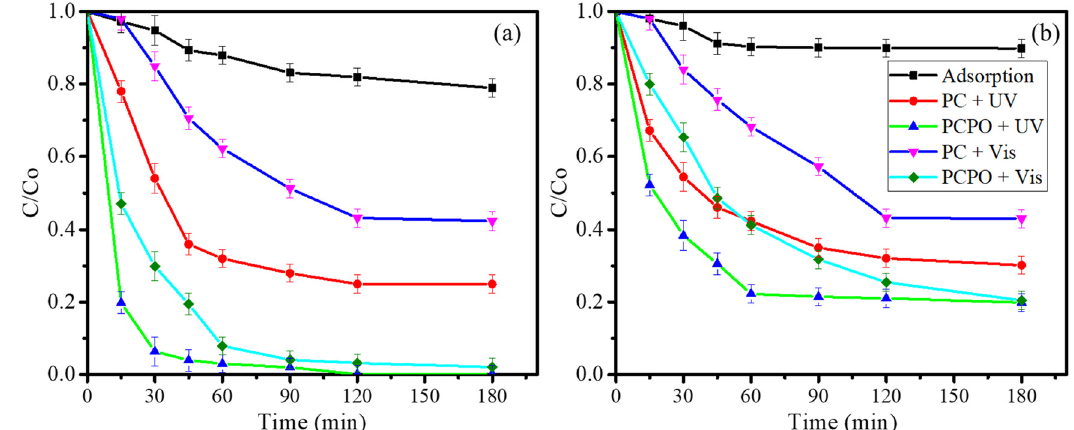
Figure 6: Kinetics plot of RhB removal utilizing various methods on ( a ) Fe 3 O 4 @SiO 2 and ( b ) Fe 3 O 4